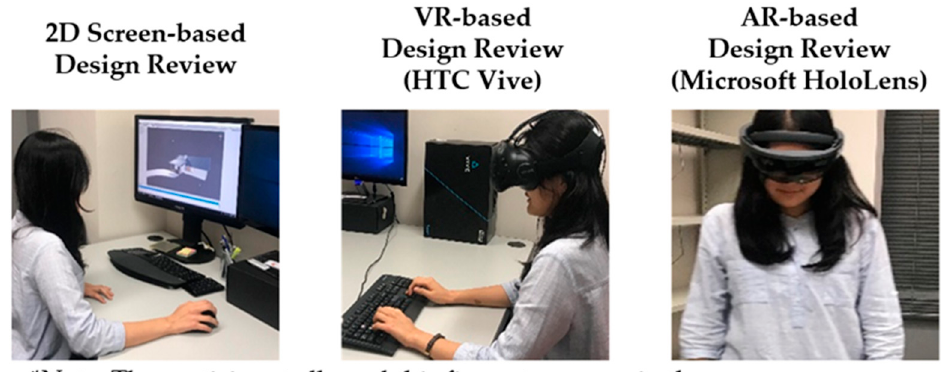
Figure 3. Display platform for each subject group.